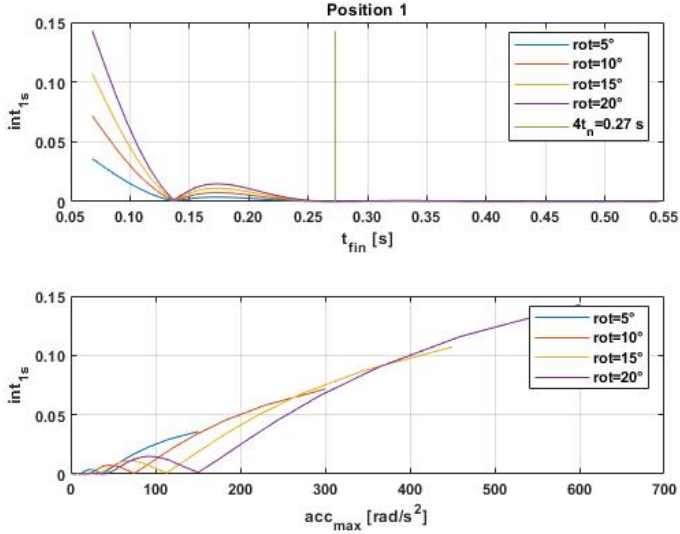
Figure 9. Index int 1s as function of t fin , acc max and rotation amplitude (rot) actuating bushing 2 in calibration position.